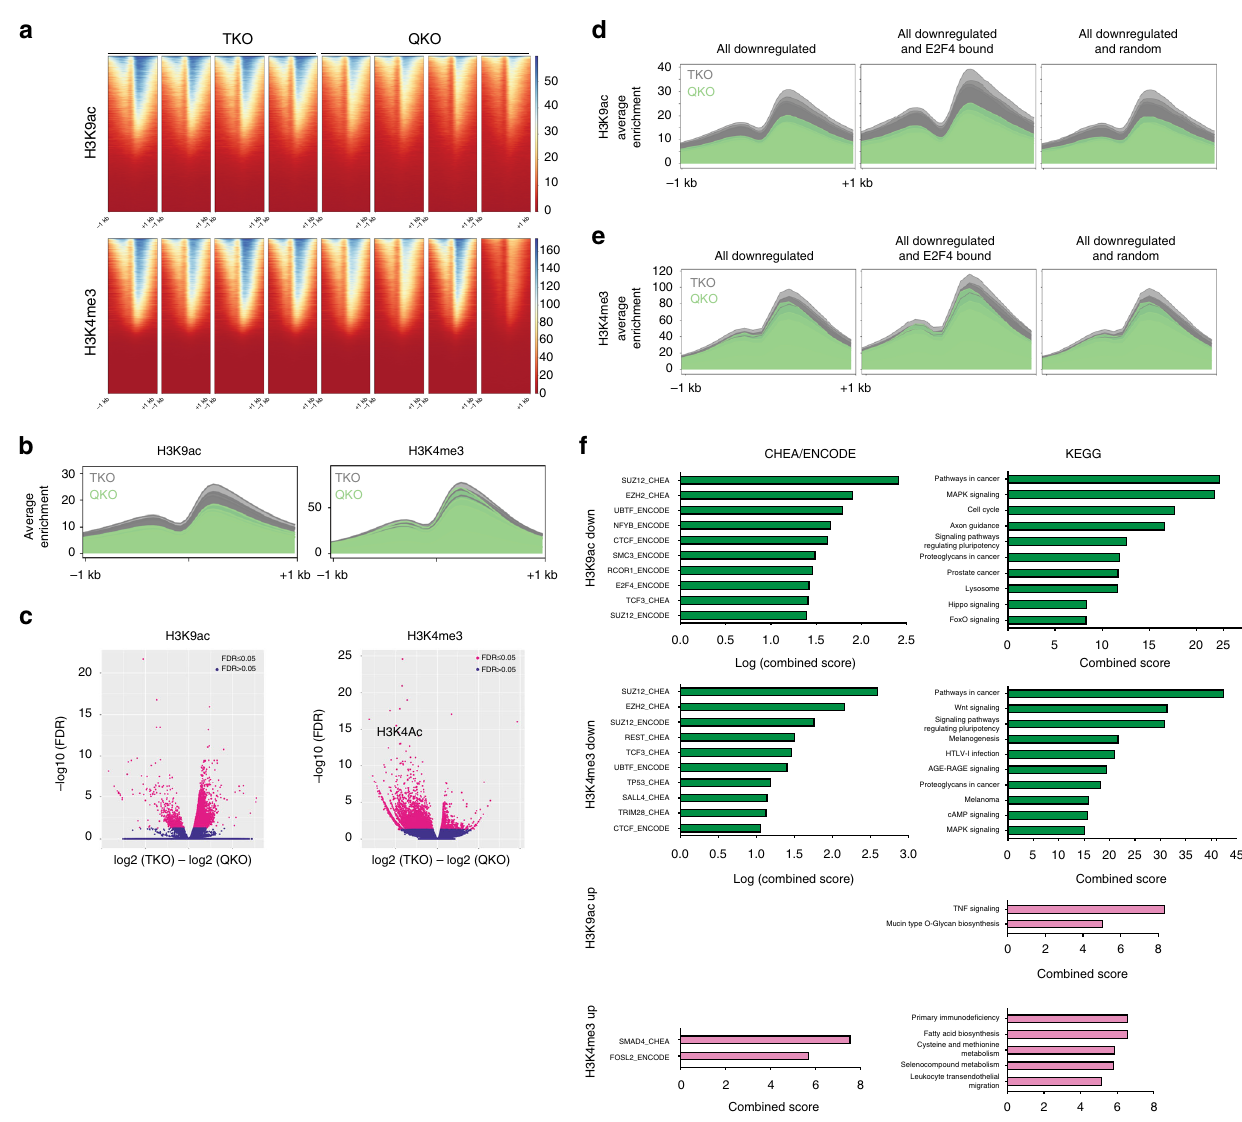
Fig. 8 ChIP-seq analysis of the role of E2F4 in gene activation in mouse ES cells. a Heatmap of enrichment scores of H3K9ac and H3K4me3 ChIP-seq signal across transcription start sites (TSS, − 1/ + 1 kb) in 2 biological replicates of 2 TKO and 2 QKO clones (biological replicates are next to each other). b Average enrichment of H3K9ac and H3K4me3 signal around TSS (-1/ + 1 kb) in TKO and QKO clones. c Volcano plot showing genome-wide comparison of detected peaks in TKO and QKO cells for H3K9ac and H3K4me3. d , e Average enrichment of H3K9ac ( d ) and H3K4me3 ( e ) signal around TSS ( − 1/ + 1 kb) comparing all downregulated genes in QKO cells compared to TKO cells, genes that are downregulated and bound by E2F4, and a random set of downregulated genes. f Enrichr analysis of CHEA/ENCODE motifs and KEGG pathways signi fi cantly ( p < 0.05) enriched in genes with downregulated and upregulated H3K9ac and H3K4me3 signal upon E2F4 loss. Top motifs/pathways (by combined score) are